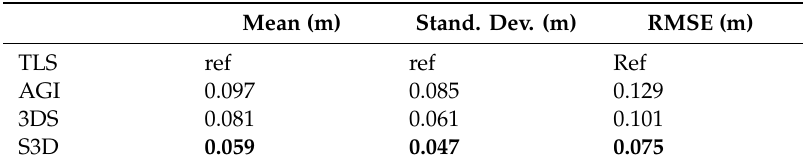
Table 12. Boulder No. 2: point